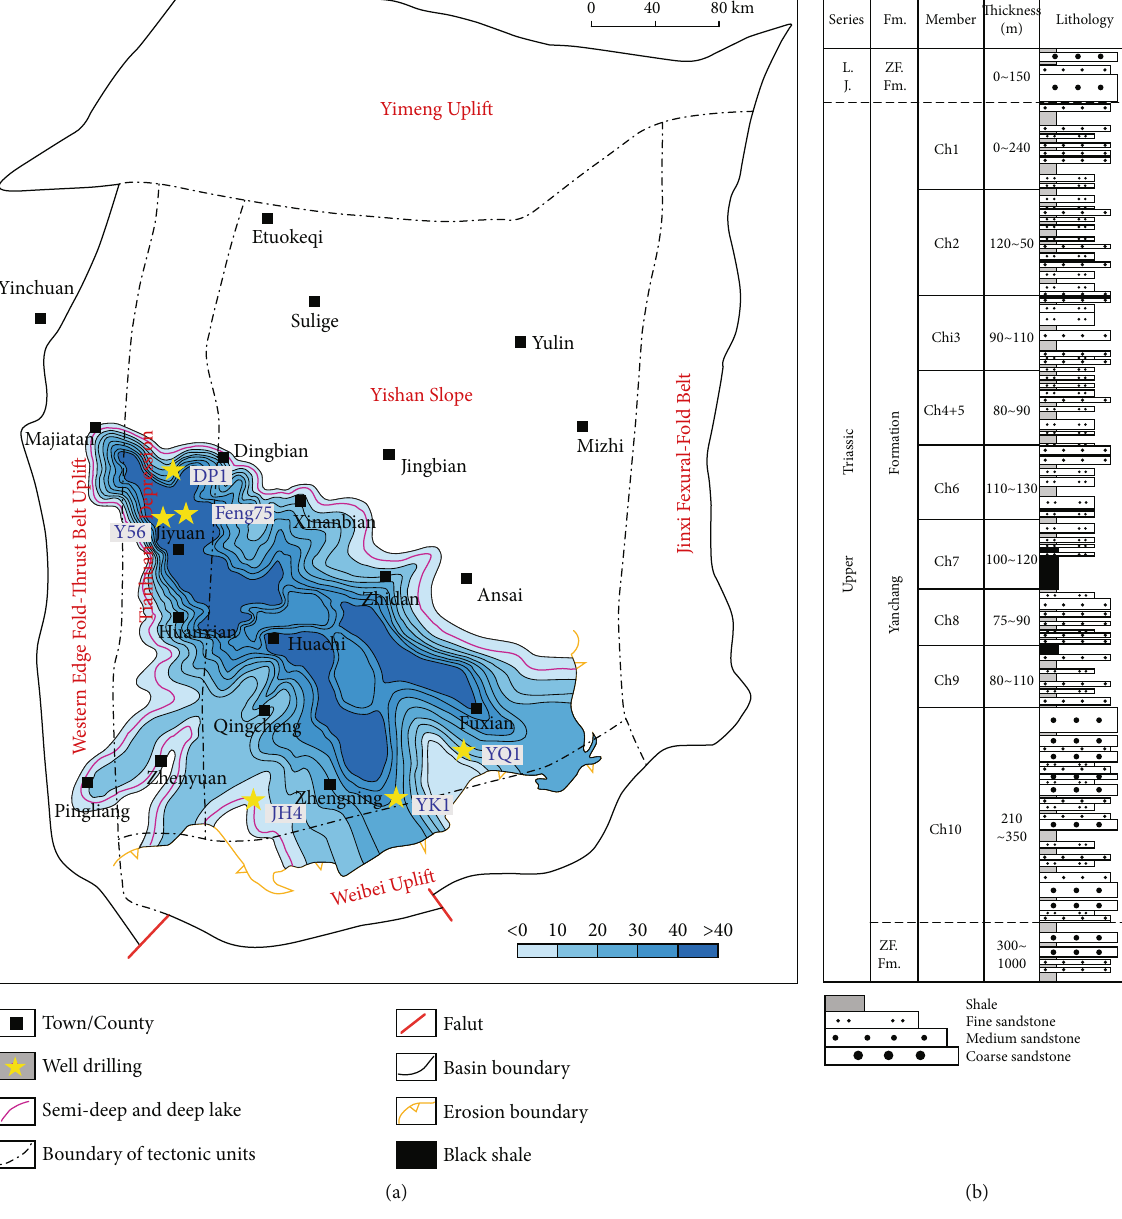
Figure 1: (a) The simpli fi ed tectonic map and distribution of Chang 7 members in the Ordos Basin. (b) Stratigraphic column of late Triassic Yanchang Formation in the Ordos Basin. Note that yellow pentagram represents the related drillings in the discussion. This fi gure is modi fi ed from Fu et al.